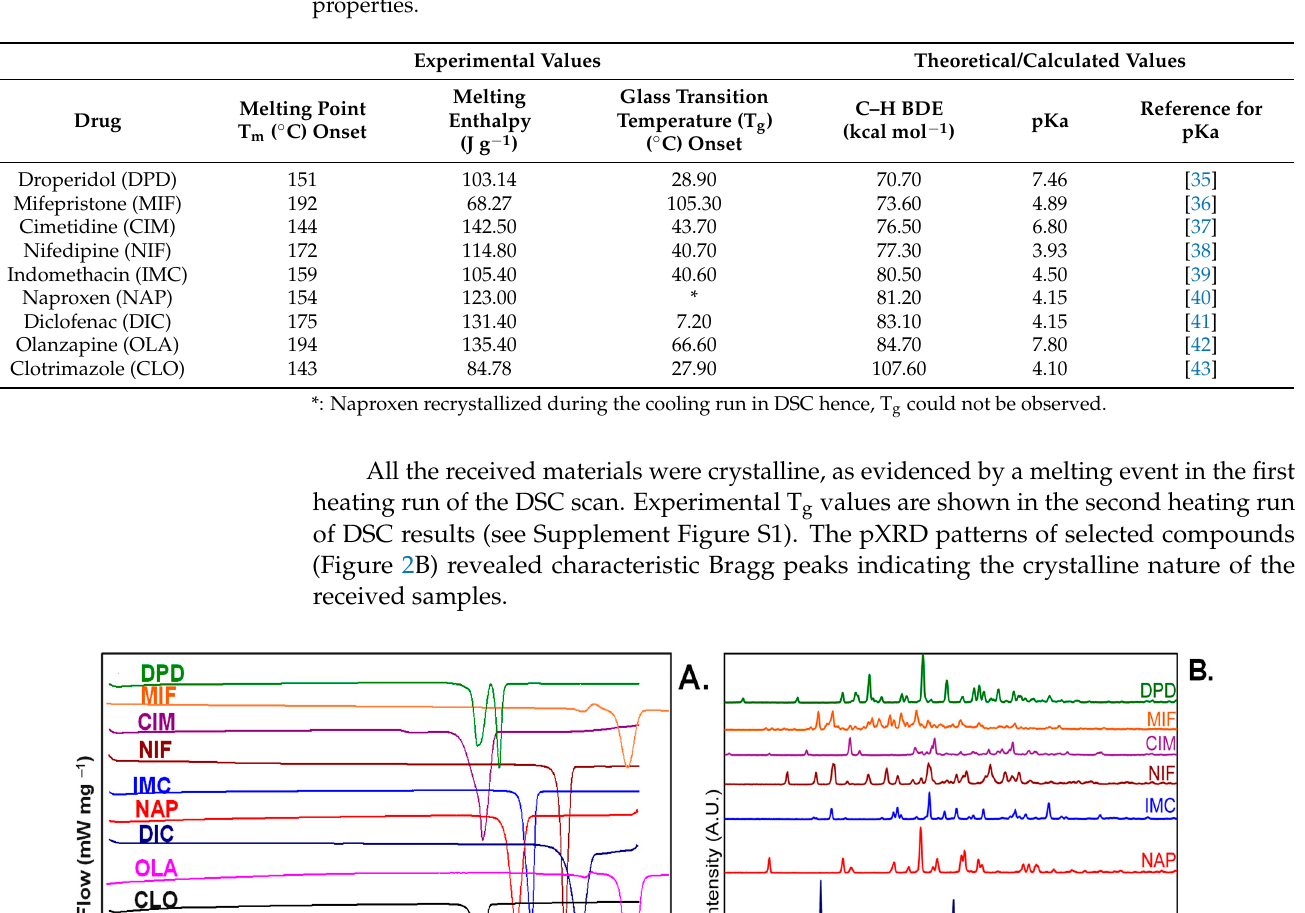
Table 1. List of selected compounds for solid- and solution-states autoxidation study and their properties.